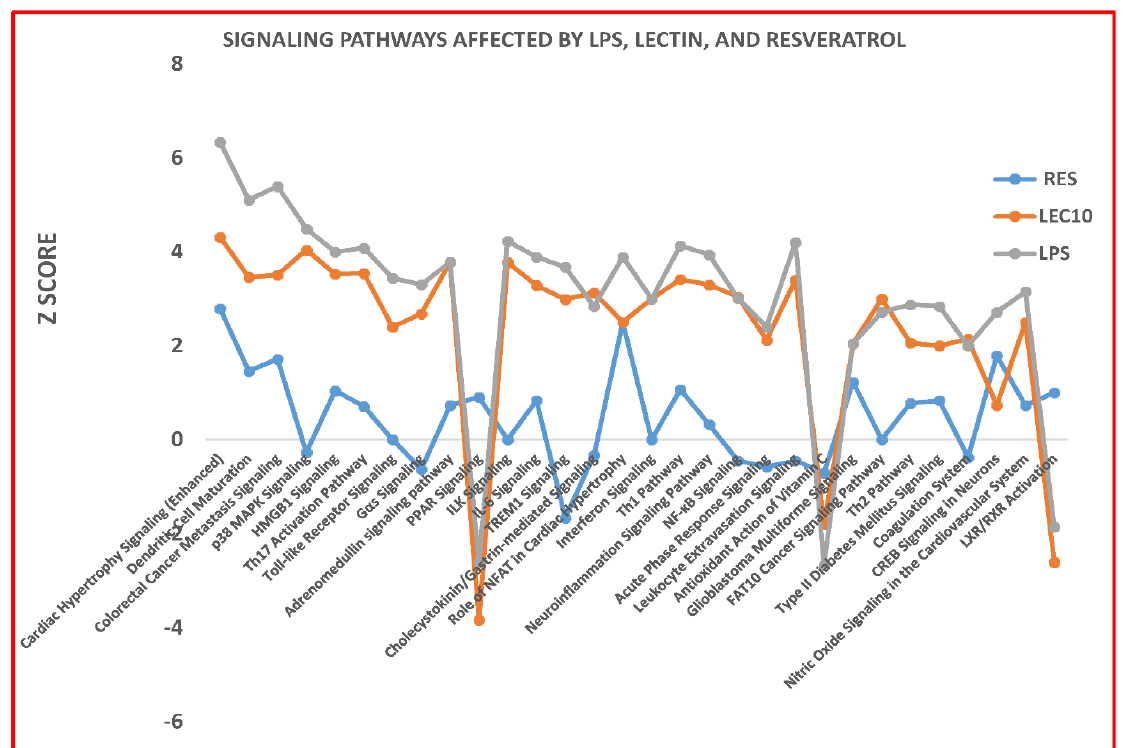
Figure 2. The role of LPS, LEC10 and RES on gene expression of mediators involved in the agonist- induced signaling pathways. The Log2 ratios of data obtained by the DEG program were downloaded into Ingenuity Pathways Analysis Program and Z score values (higher Z scores represent significant pathways) were obtained. Z scores against the signaling pathways were plotted.